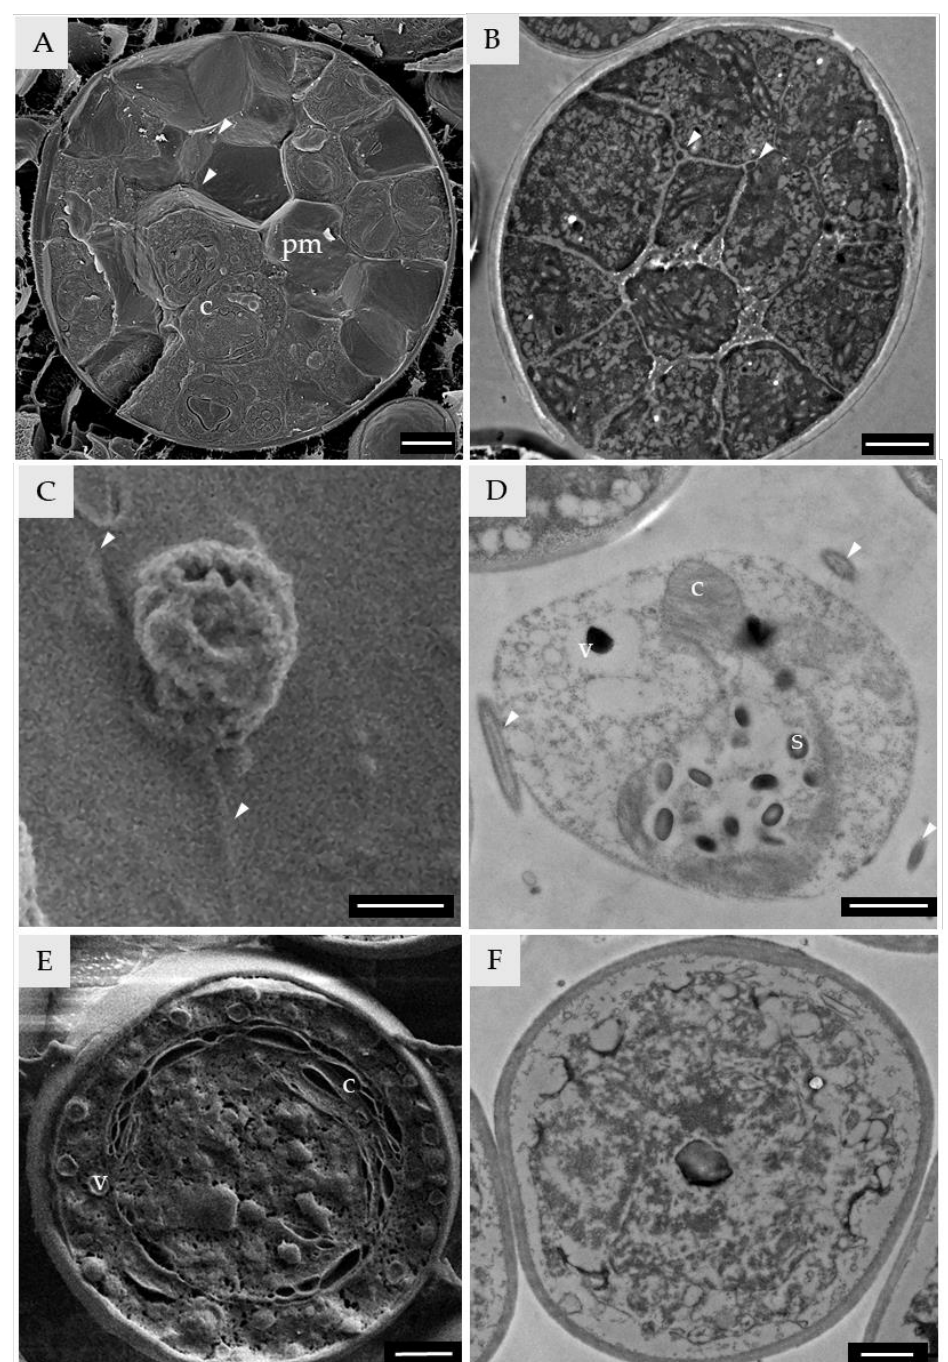
Figure 4. LTSEM ( A , C , E ) and TEM ( B , D , F ) of Trebouxia lynnae zoosporangia, zoospores, and senescent cells. ( A , B ) Zoosporangia. ( C , D ) Zoospores. ( E , F ) Senescent cells. Chloroplast (c), vesicles (v), starch grains (s), and plasma membrane (pm) are indicated with letters. Flagella are indicated by a white arrowhead. Scale bars: ( A , B ) 2 µ m, ( C – F ) 1 µ